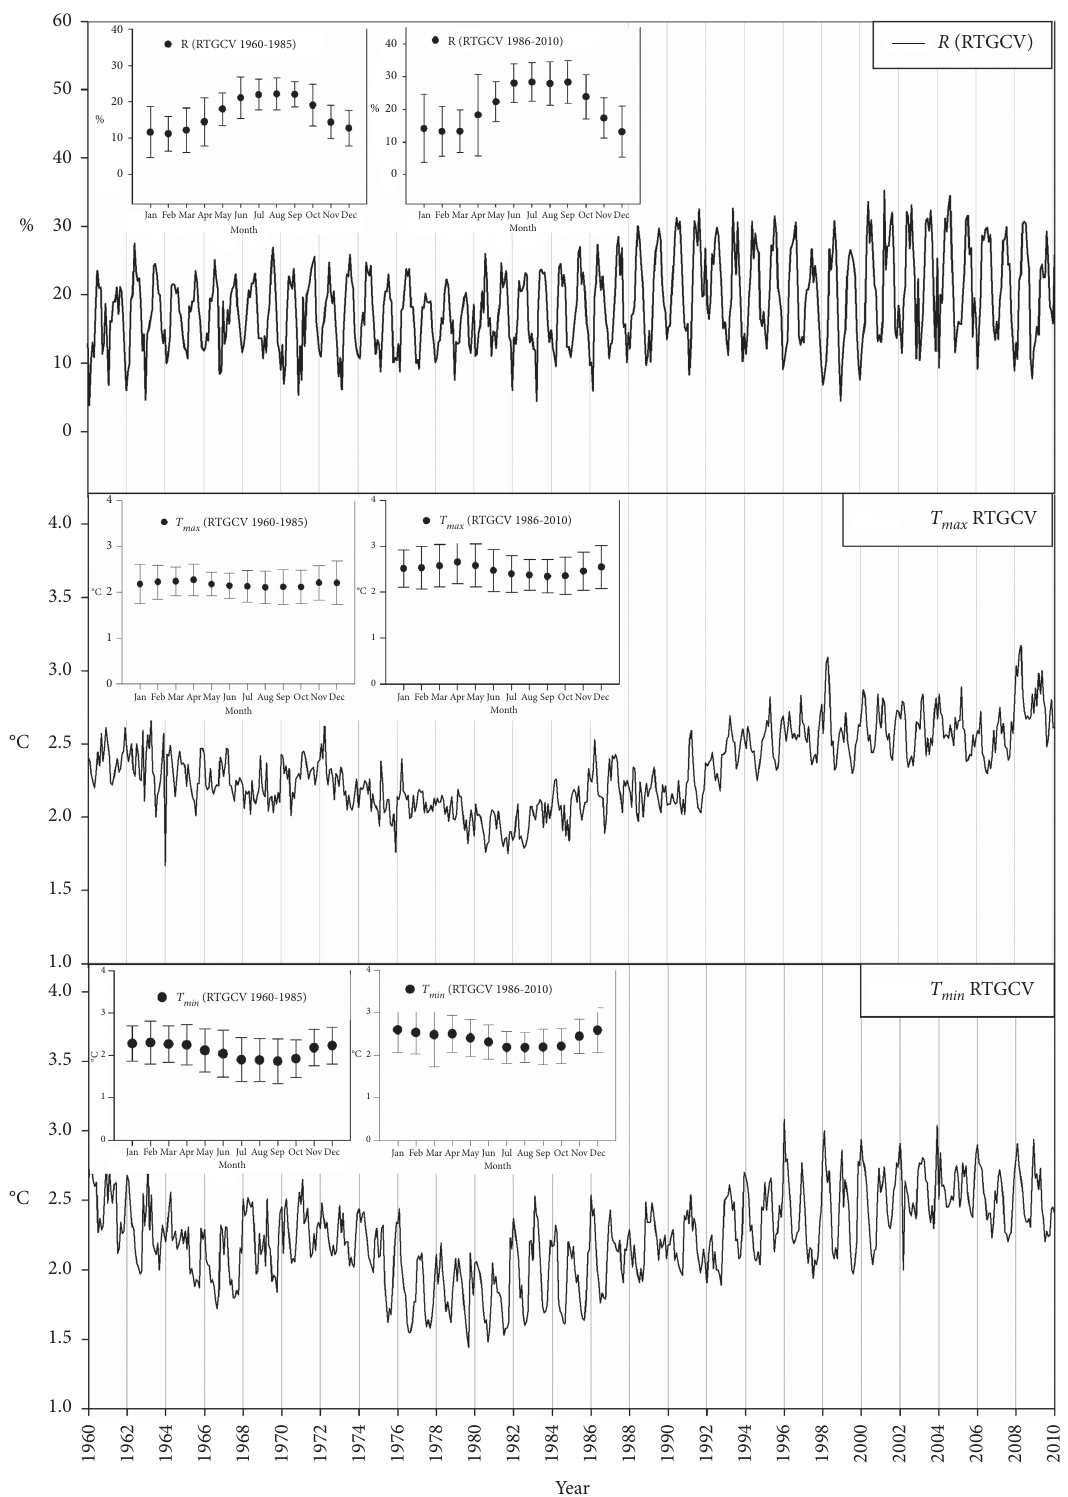
Figure 4: RTGCV of monthly R, Tmax, and Tmin for the entire study period and the initial and final periods (1960–1985 and 1986–2010) in the Lerma-Chapala-Santiago